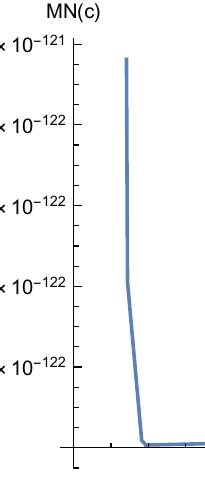
√ 2 and σ = 10 − 1 . MN curve for = 0.1 (cid:1)